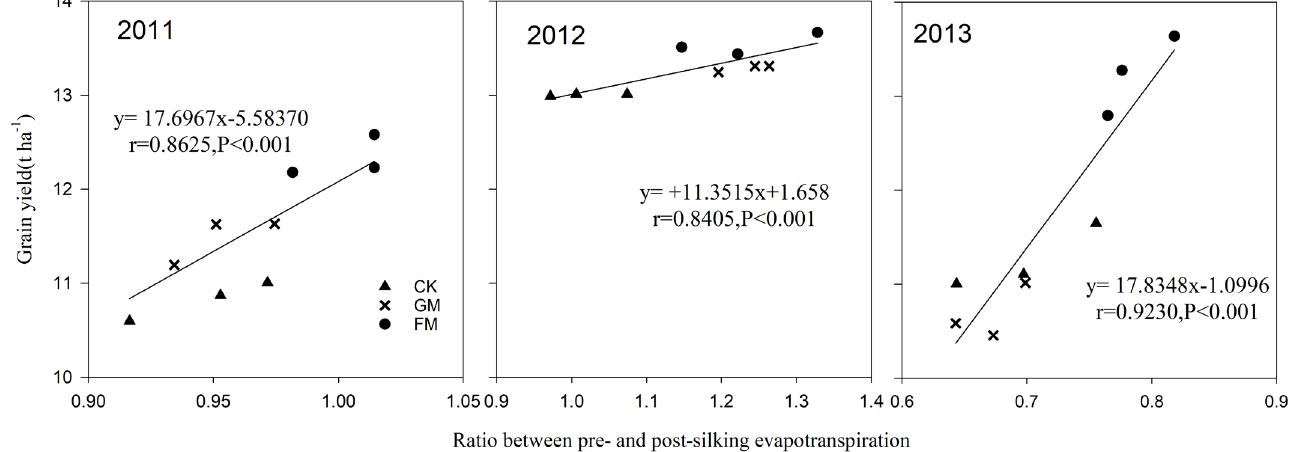
Figure 7. Correlations between grain yield and the ratio between pre − and post − silking water consumption of maize under the non − mulched (CK), gravel mulching (GM), straw mulching (SM), and plastic film mulching (FM) treatments in 2011, 2012, and 2013. Table 2. Maize grain yield (GY) and water-use efficiency (WUE) under the non-mulched (CK), gravel mulching (GM), straw mulching (SM), and plastic film mulching (FM) treatments.